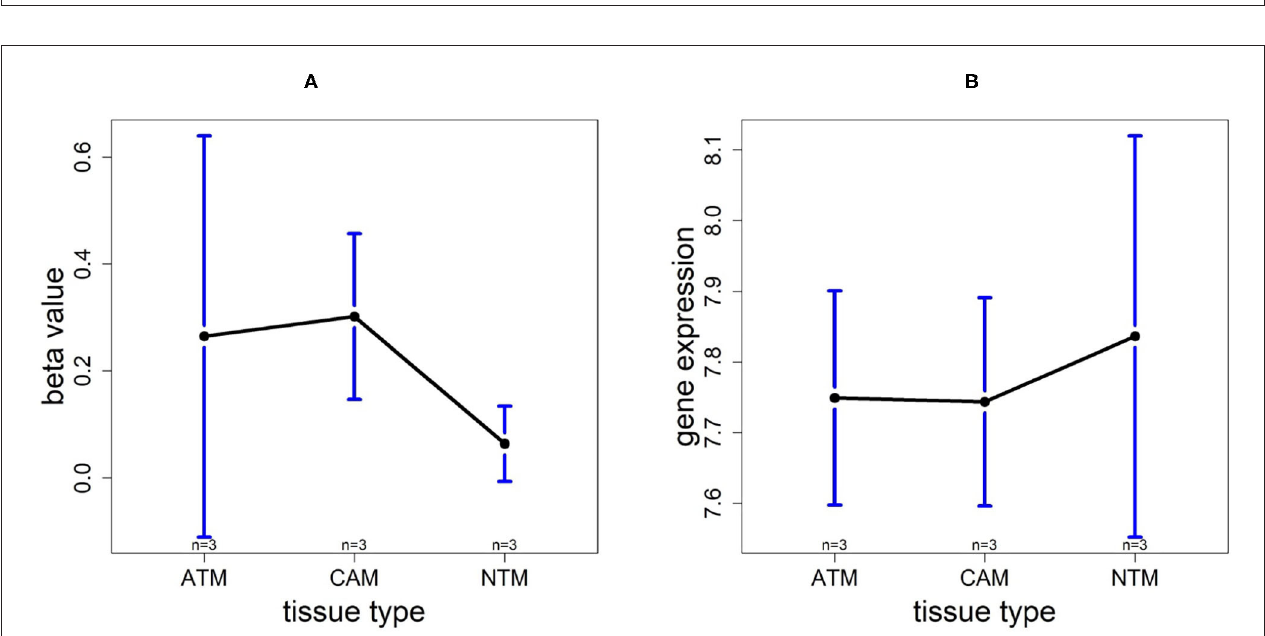
FIGURE 13 | The overall methylation and gene expression levels of the FOXP2 promoter region. (A) Averaged methylation level over the three samples of gene FOXP2 among tissue types from GSE97686 dataset. (B) Averaged gene expression level over the three samples of gene FOXP2 among tissue types from GSE107161 dataset. The blue bars represent 95% confidence intervals. Some error bars are large as the sample size is only 3 in each tissue type.